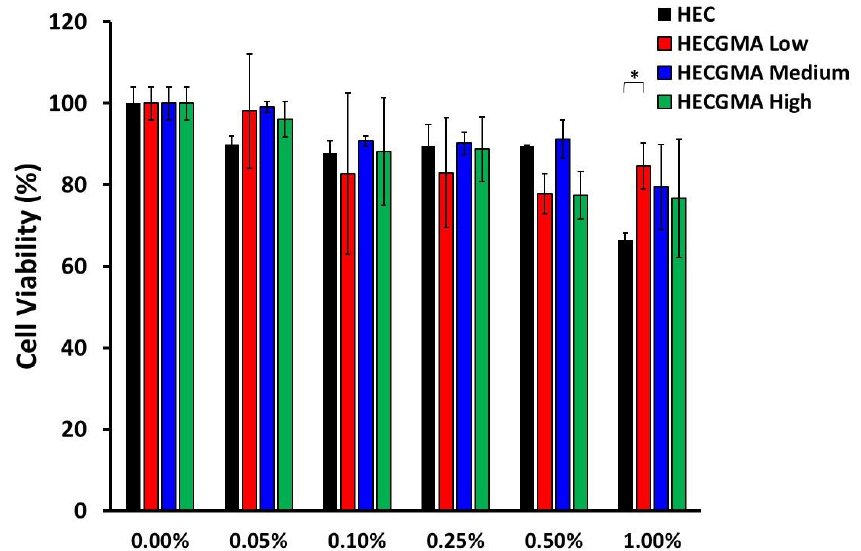
Figure 5. Cell viability evaluated using MTT assay with the percentage of viable cells after the exposure to: 0%, 0.05%, 0.10%, 0.25%, 0.50%, and 1.00% of HEC and HECGMA derivatives at 24 h. Data show the mean values ± SD (n = 3). * Statistical significance is shown according to t -test; p < 0.05.